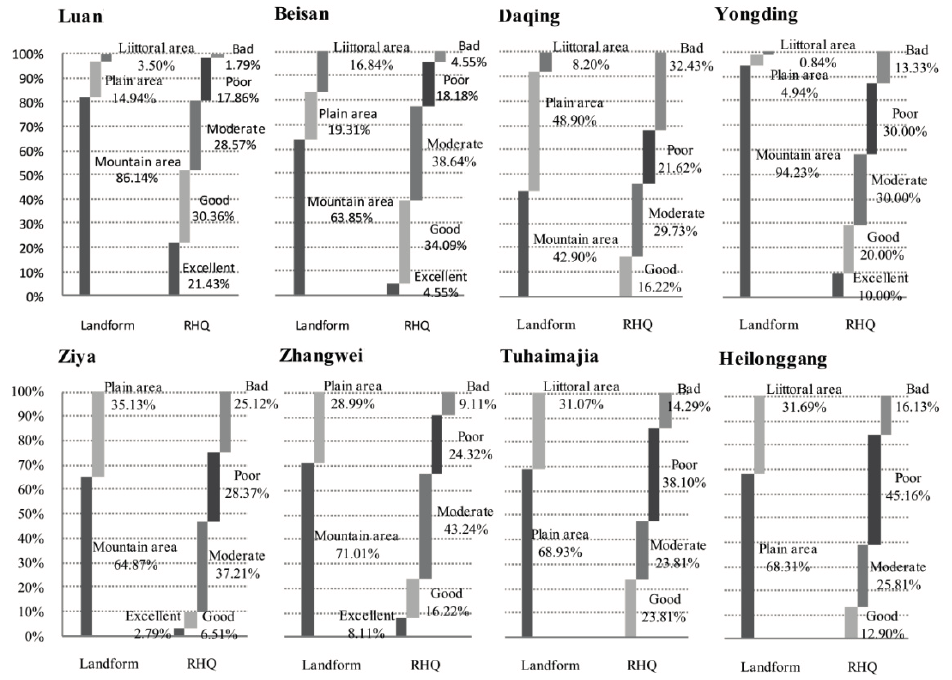
Figure 4. Percentage of different land forms and RHQ in each secondary river